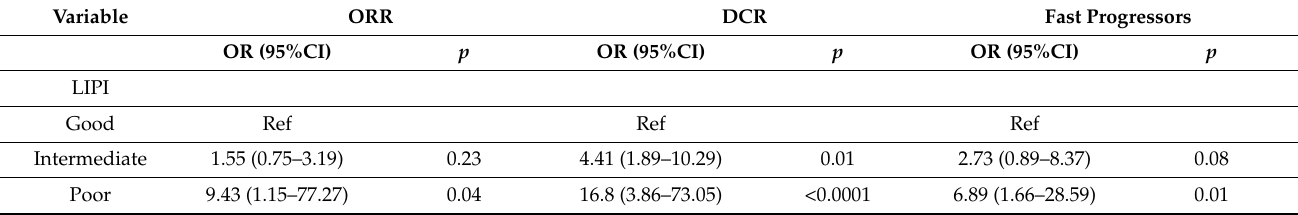
Table 4. Univariate logistic regression for response endpoints according to LIPI